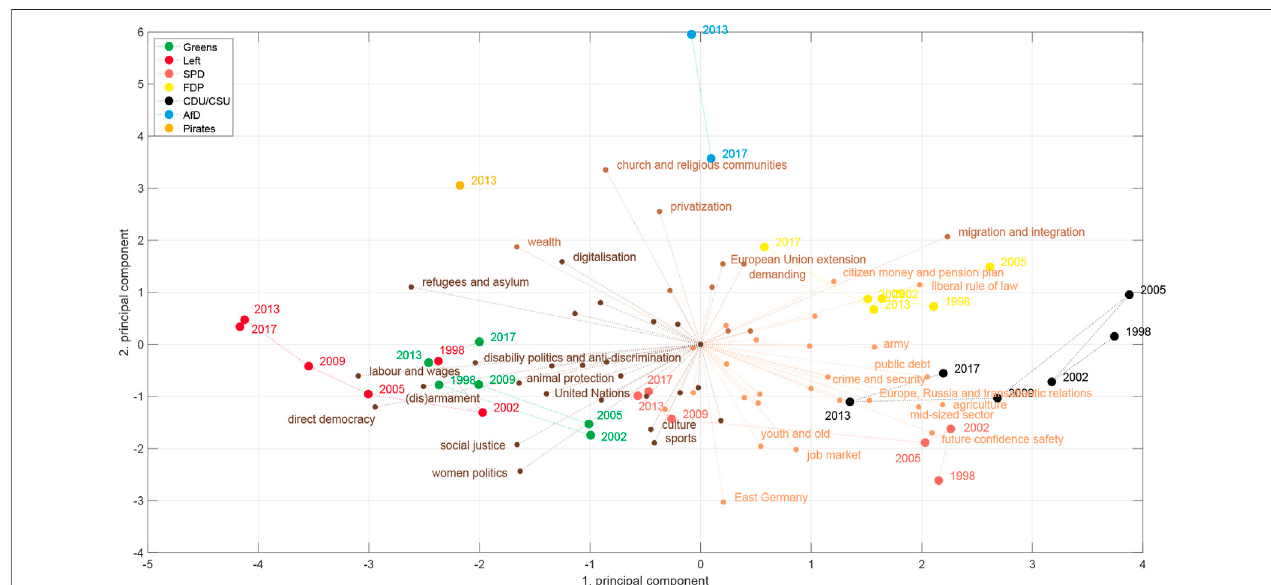
FIGURE 9 | Same as in Figure 7 but now using the topic probabilities from topic model A.